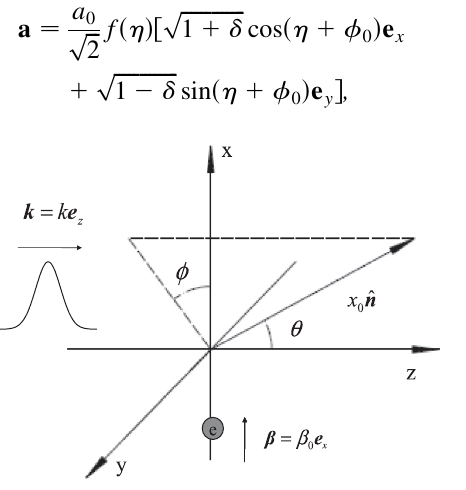
ffiffiffiffiffiffiffiffiffiffiffiffiffi p 1 þ (cid:2)